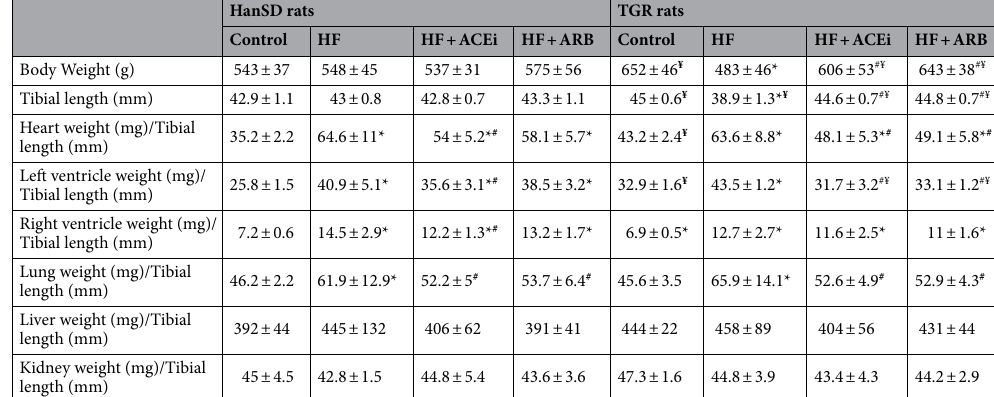
Table 1. Body weights, tibial lengths and ratios of organ weights to tibial lengths in control, untreated heart failure (HF), ACE inhibitor-treated (HF + ACEi) and AT 1 receptor blocker-treated (HF + ARB) HanSD and TGR rats. Please note that data from HF TGR rats were obtain in 5 weeks after ACF induction due to high mortality. Values are expressed as mean ± standard deviation and consist of ten observations per group. * P < 0.05 versus control of the same rat strain # P < 0.05 versus HF of the same rat strain ¥ P < 0.05 versus HanSD